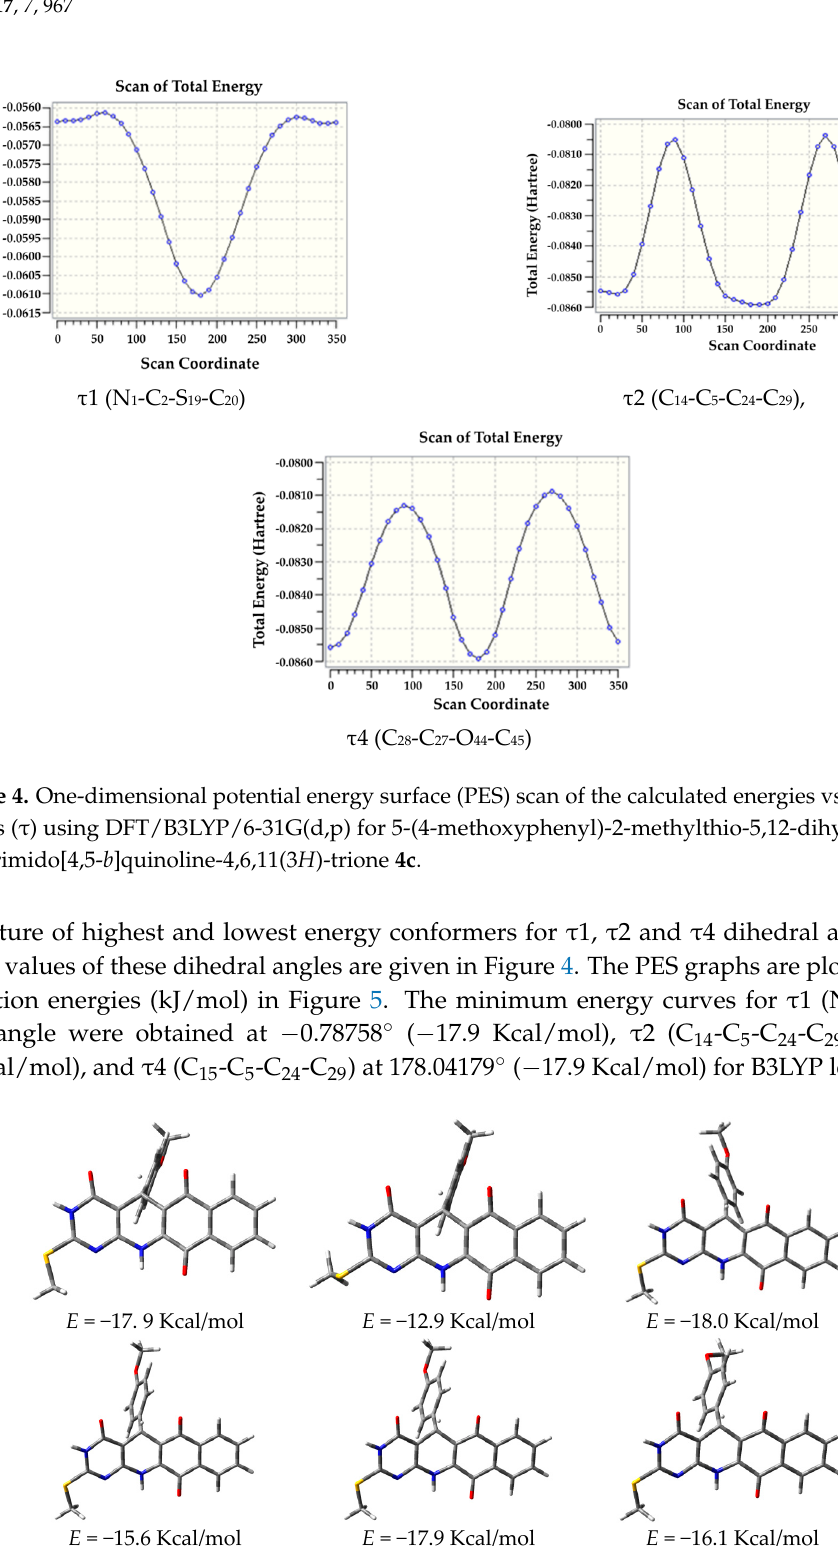
Table 4. Fourier Transform infrared spectroscopy (FT-IR) Experimental and computed vibrational bands for compound 4c and their assignments at B3LYP/6-31G(d,p) level. υ